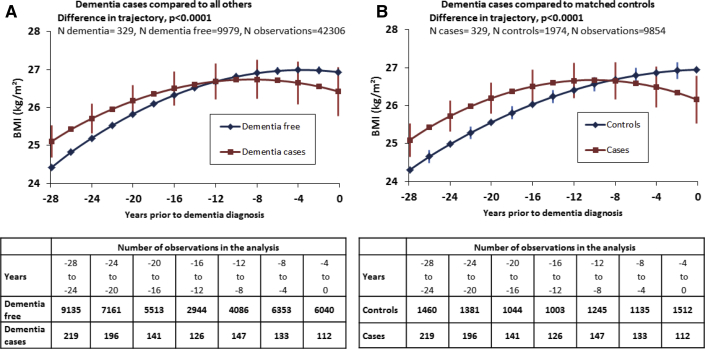
Trajectories of BMI in the 28 years before dementia. (1) The figure represents marginal effects of dementia on trajectories of BMI, adjusted for age, sex, and education and 5-year birth cohort in panel (A). Mean number of observations per participant is 3.3 for dementia cases and 4.1 for those dementia free for approach (A) and 4.4 for control subjects for approach (B). (2) The 95% confidence intervals are presented for alternate time points for ease of presentation.